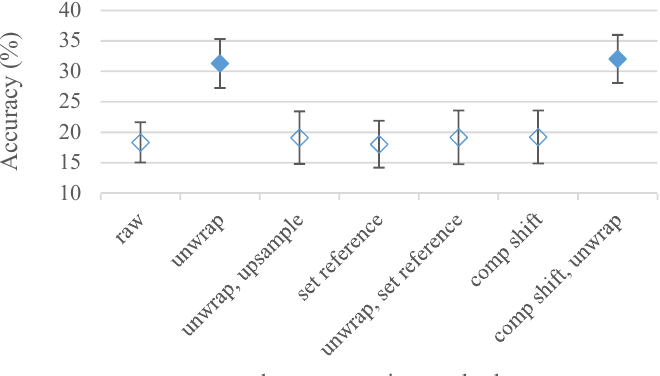
Figure 18. Averaged accuracies and standard deviations for phase spectrograms using following modifications: raw, unwrap, up sampled and unwrap, set reference phase, unwrap and set reference phase, shift compensation, and shift compensation and unwrap in the case of an 8 kHz maximal frequency. Filled marks show equally performing settings.